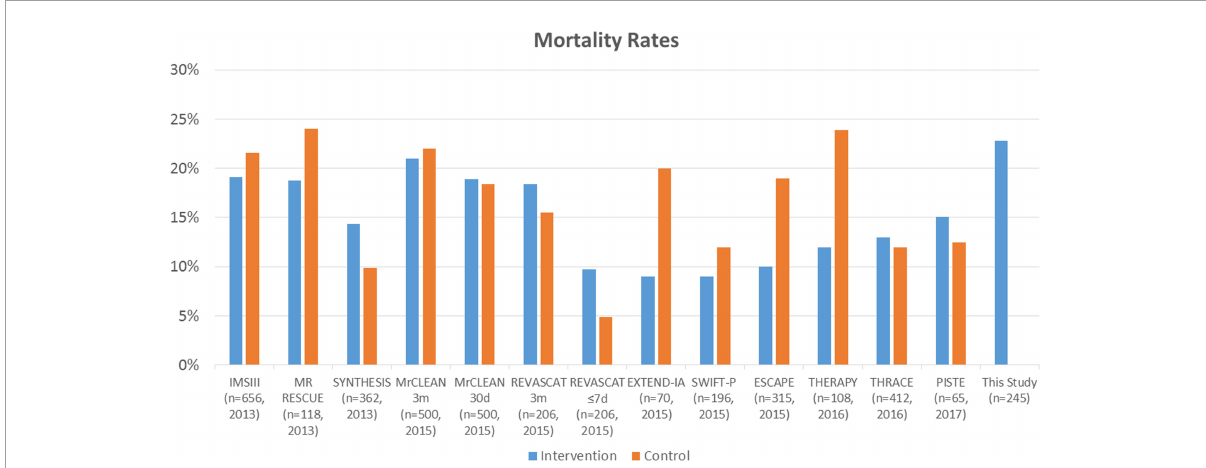
FIGURE1 Summary of randomized clinical trials assessing the effect of endovascular thrombectomy (EVT) compared with standard care on mortality rates and this study. Blue: intervention and EVT. Orange: controls and standard therapy.